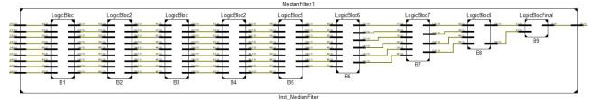
Fig. 11. RTL Schematic for the median filter